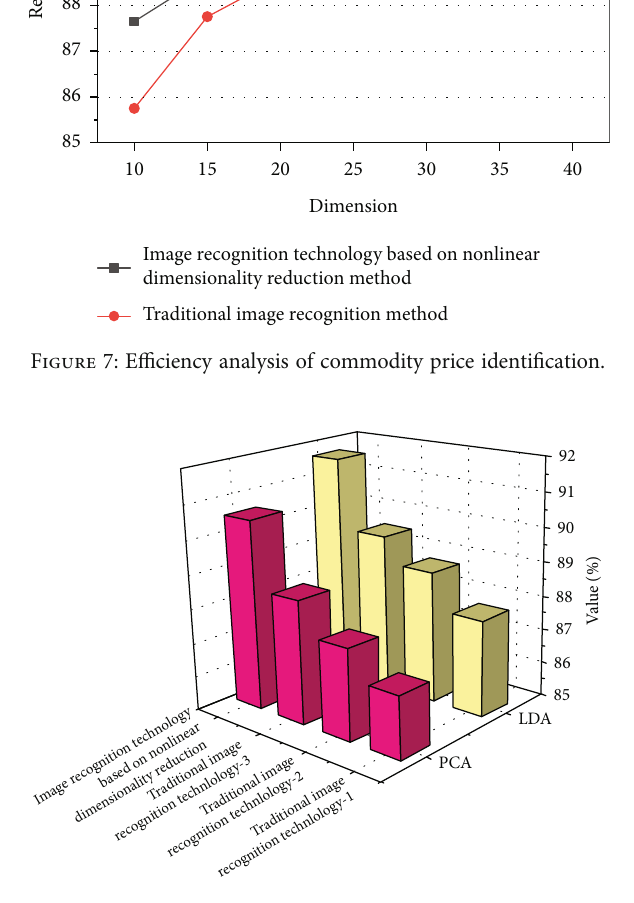
Figure 8: Analysis of commodity price recognition results under di ff erent feature extraction methods.